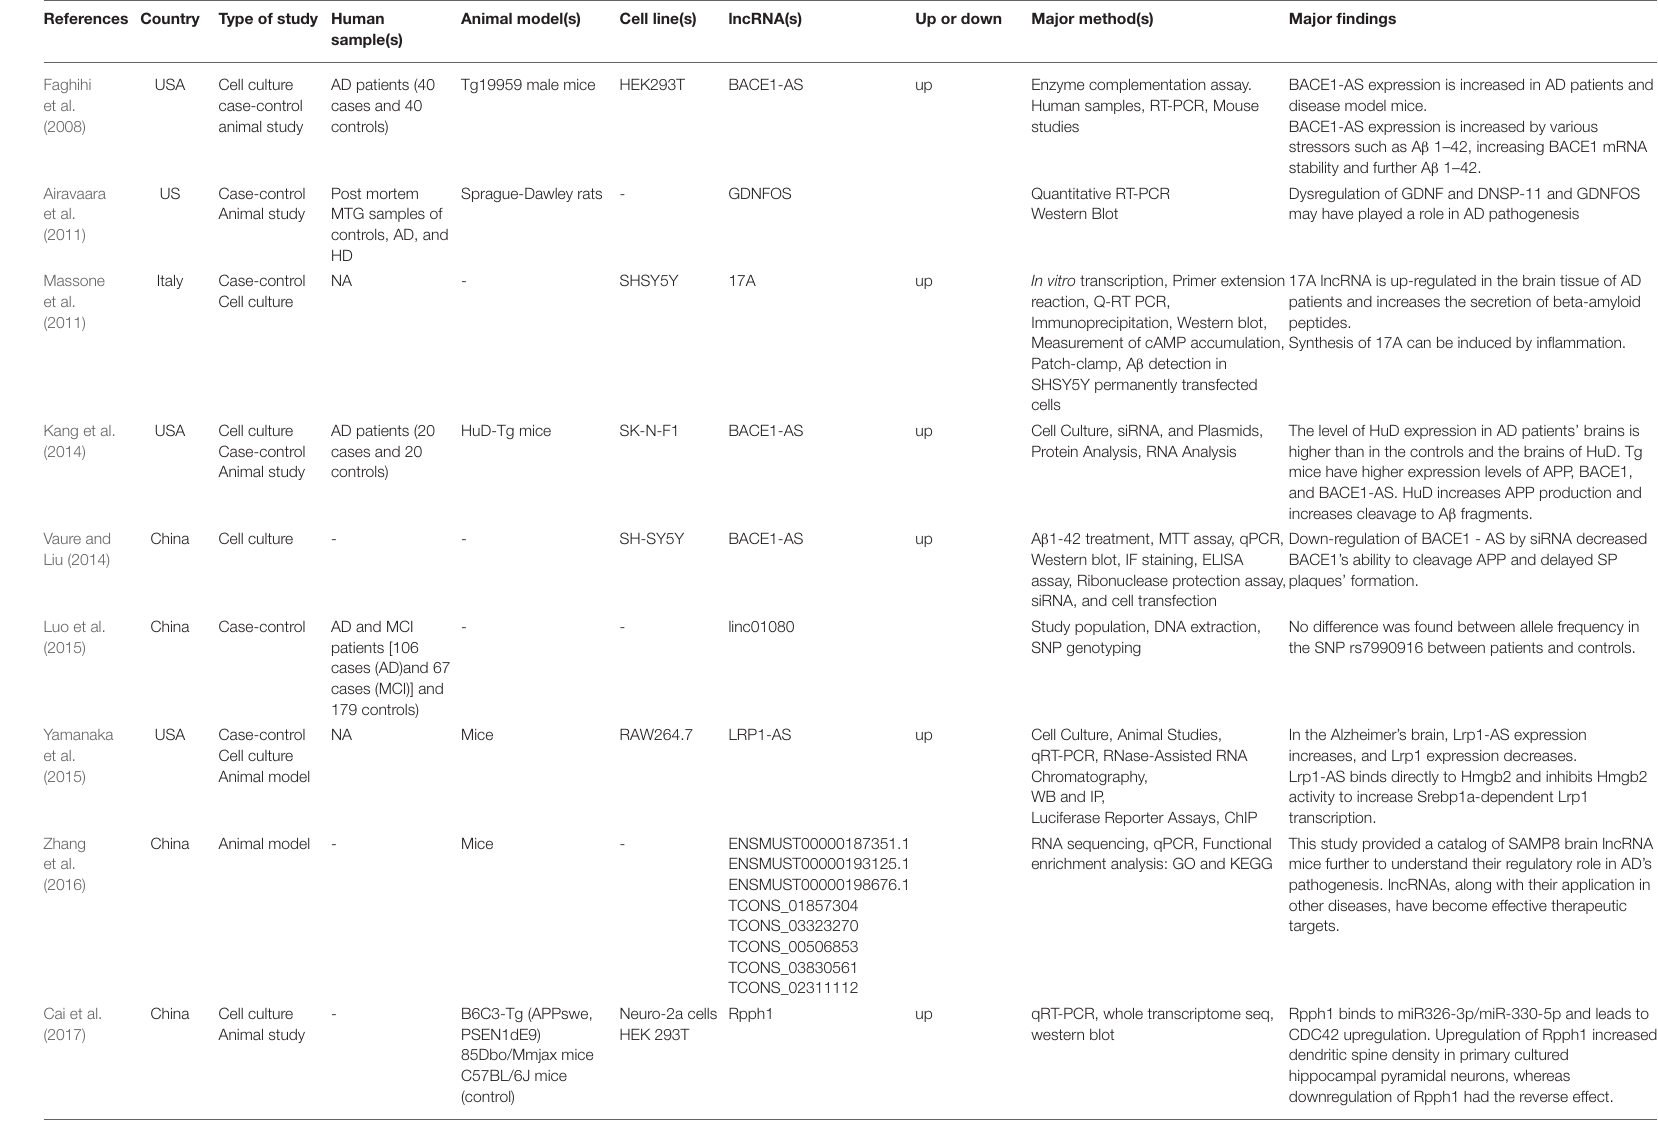
TABLE 3 | LncRNAs in Alzheimer’s